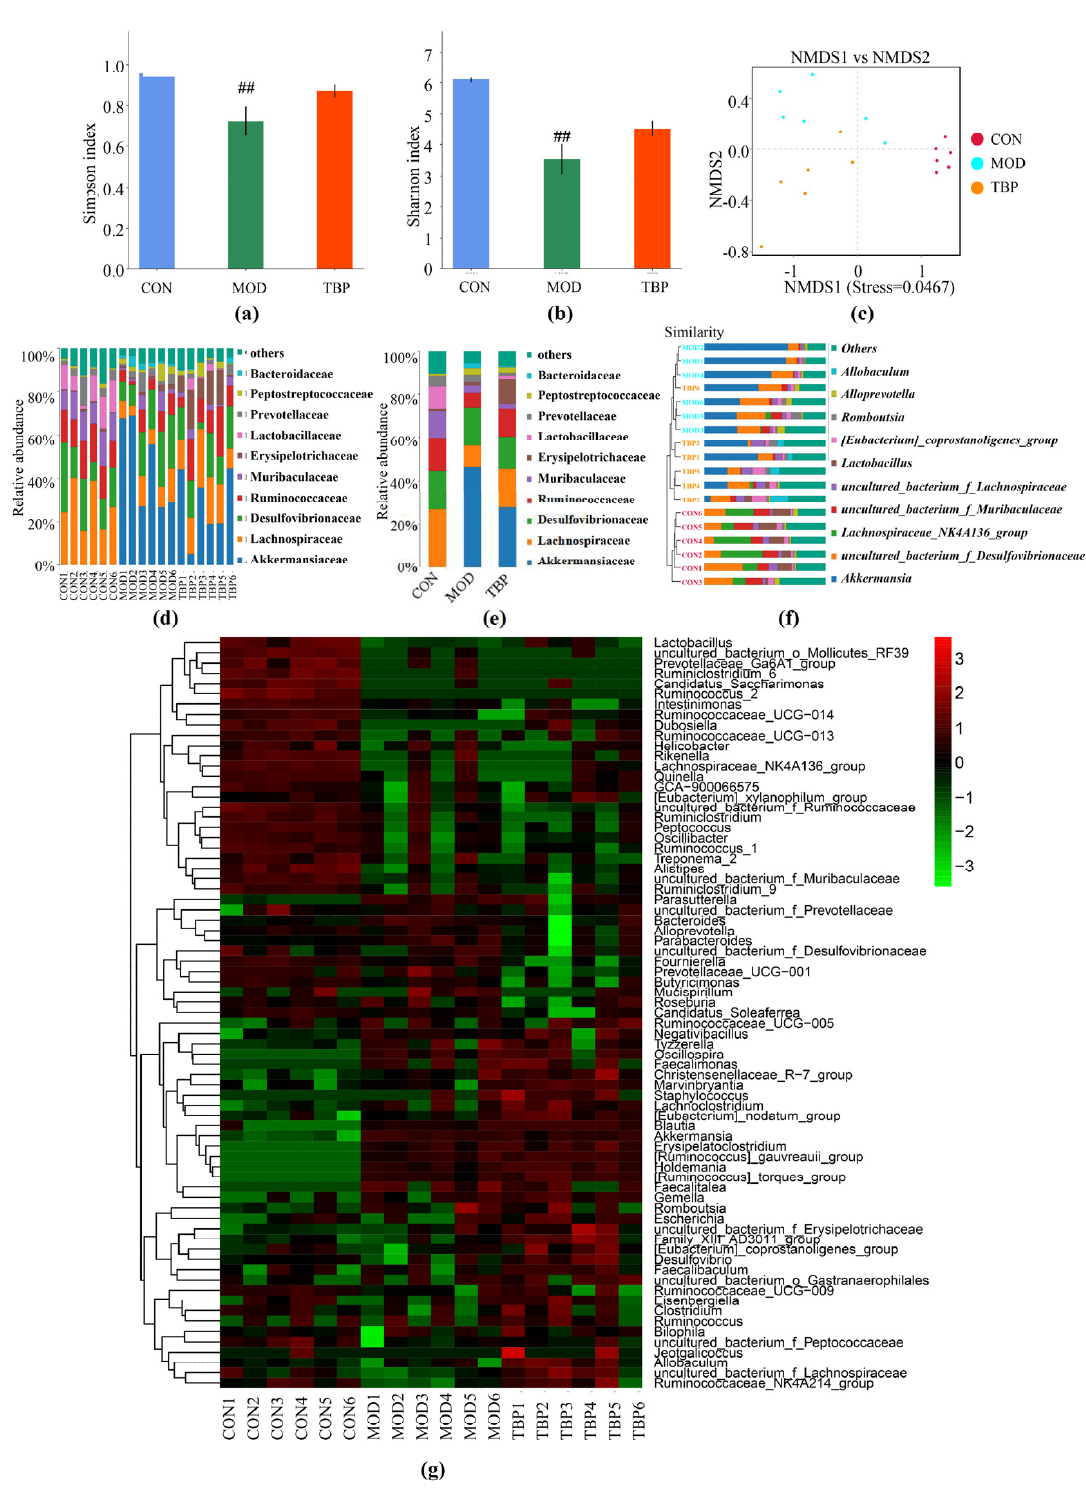
Figure 7. Effect of TBP on gut microbiota in the HFD-fed rats. ( a ) The alpha diversity of Simpson index. ( b ) The alpha diversity of Shannon index. ( c ) The beta diversity analysis by weighted unifrac distance-based NMDS. ( d ) Relative abundances of gut microbiota in each rat at the family levels. ( e ) Relative abundances of gut microbiota in each group at the family levels. ( f ) Clustering of the microbial communities based on weighed unifrac distance (at the genus level). ( g ) Heat map of gut microbiota (at the genus level). ## p < 0.01 denotes statistically significant differences between the CON and MOD